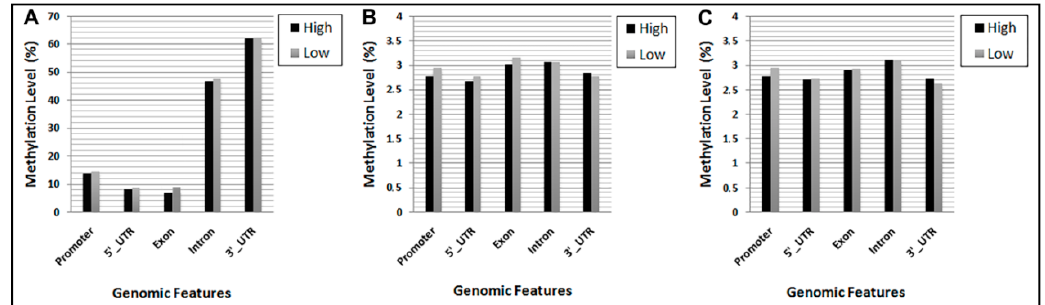
Figure 3. DNA methylation levels of different functional regions between the two high- and low-cortisol groups. ( A ) CG regions. ( B ) CHG regions. ( C ) CHH regions. H = A, C, or T.